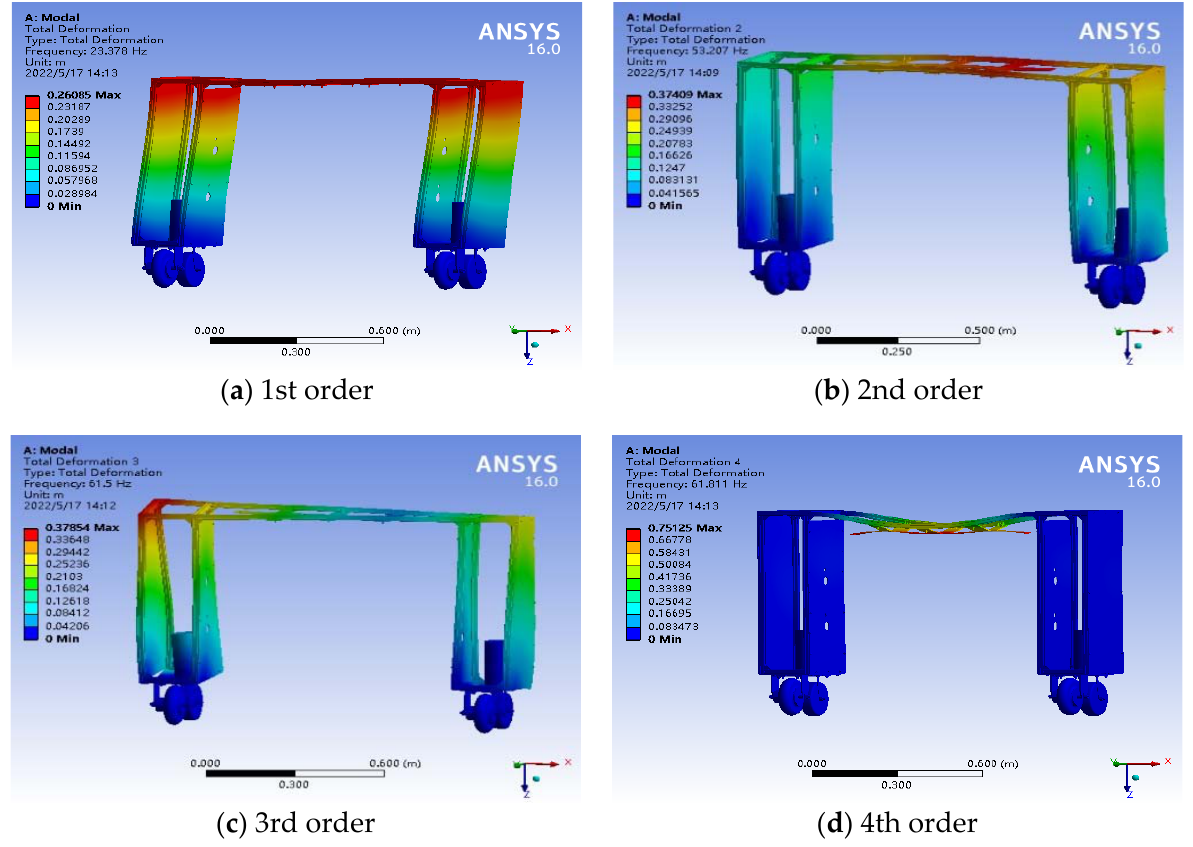
Figure 3. First fourth-order vibration diagram of the vehicle part.